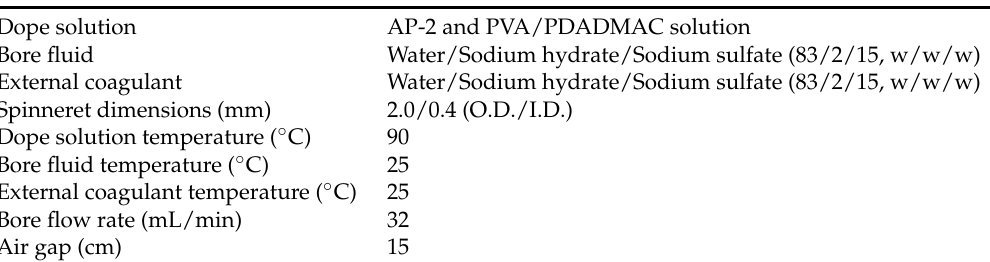
Figure 3. Schematic diagram of an apparatus of spinning hollow fiber type IEMs. Table 1. Basic spinning